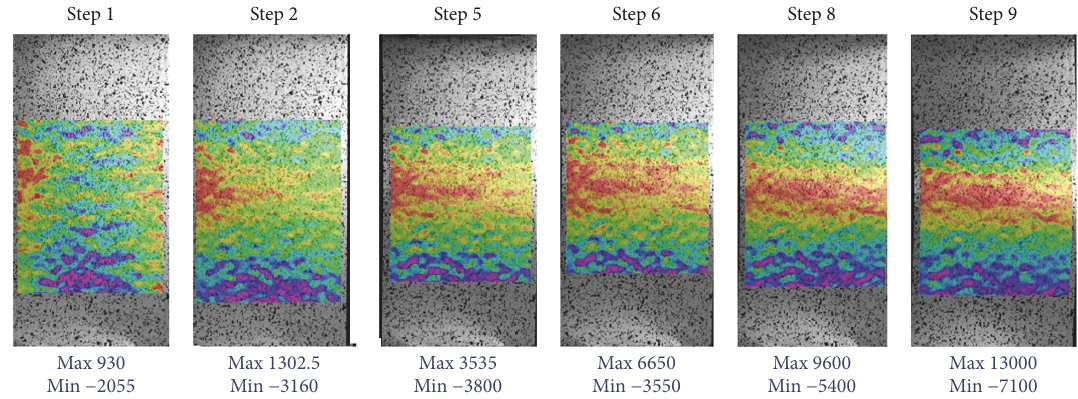
Figure 11: Surface strain-principal step-side delamination specimen [ 𝜇𝜀 ].